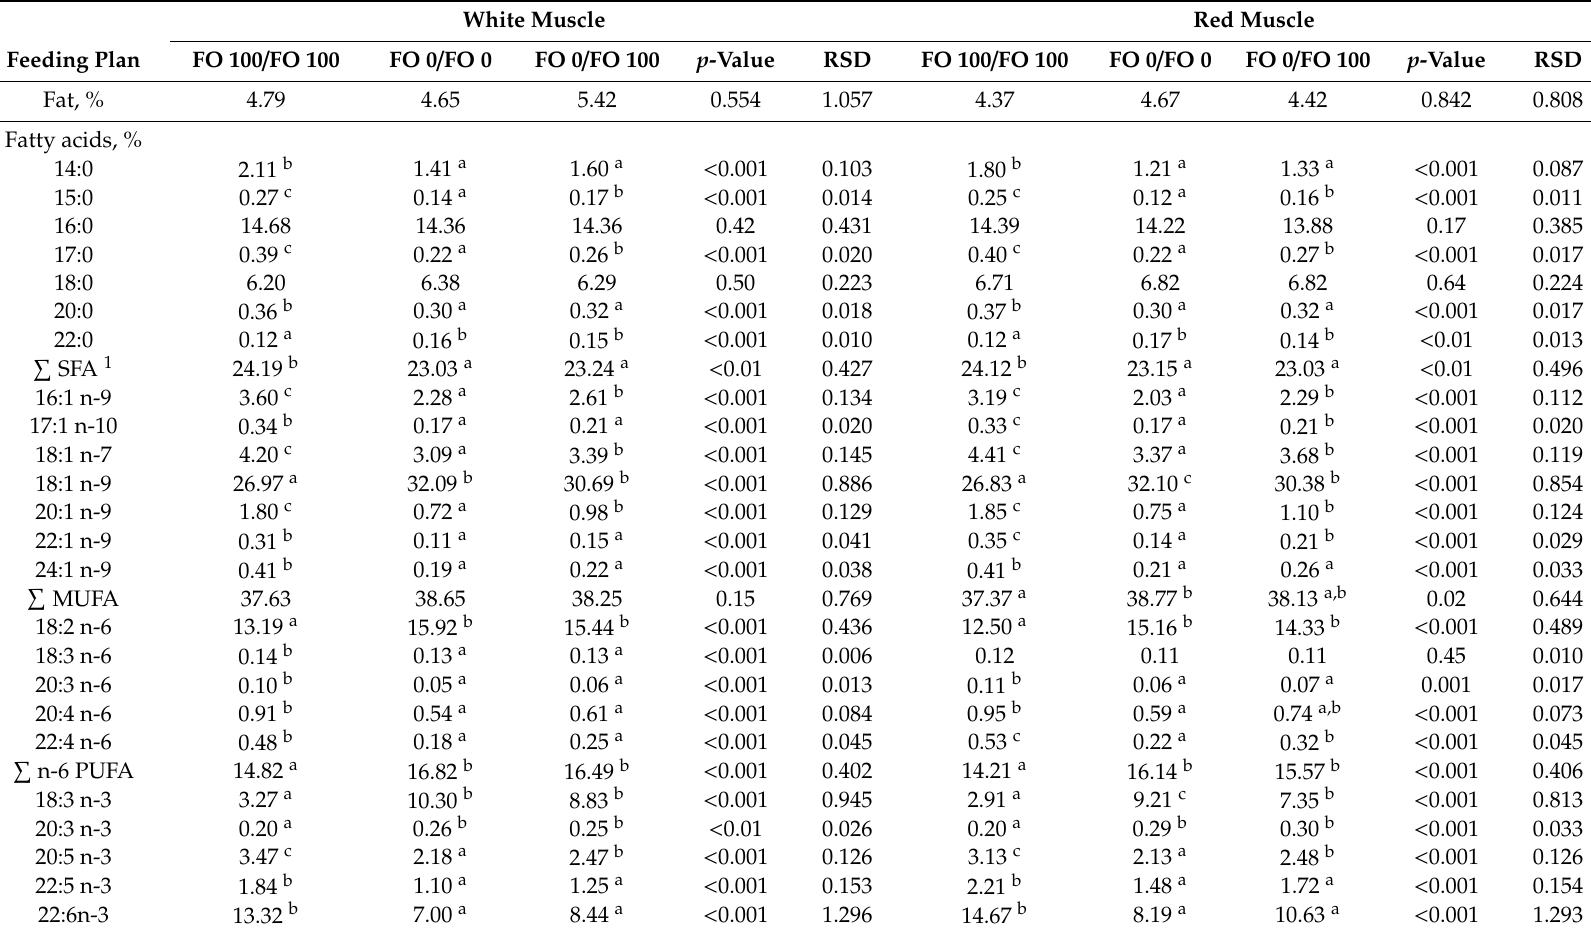
Table 3. Fat content (%) and fatty acid composition (% of total fatty acid content) of white and red muscle in S. dumerili fed FO 100 / FO 100, FO 0 / FO 0, and FO 0 / FO 100 diets after 45 d of wash-out (6 fish per feeding plan): e ff ect of the feeding plan. Values are expressed as least square (LS) means. White Muscle Red Muscle Feeding Plan FO 100 / FO